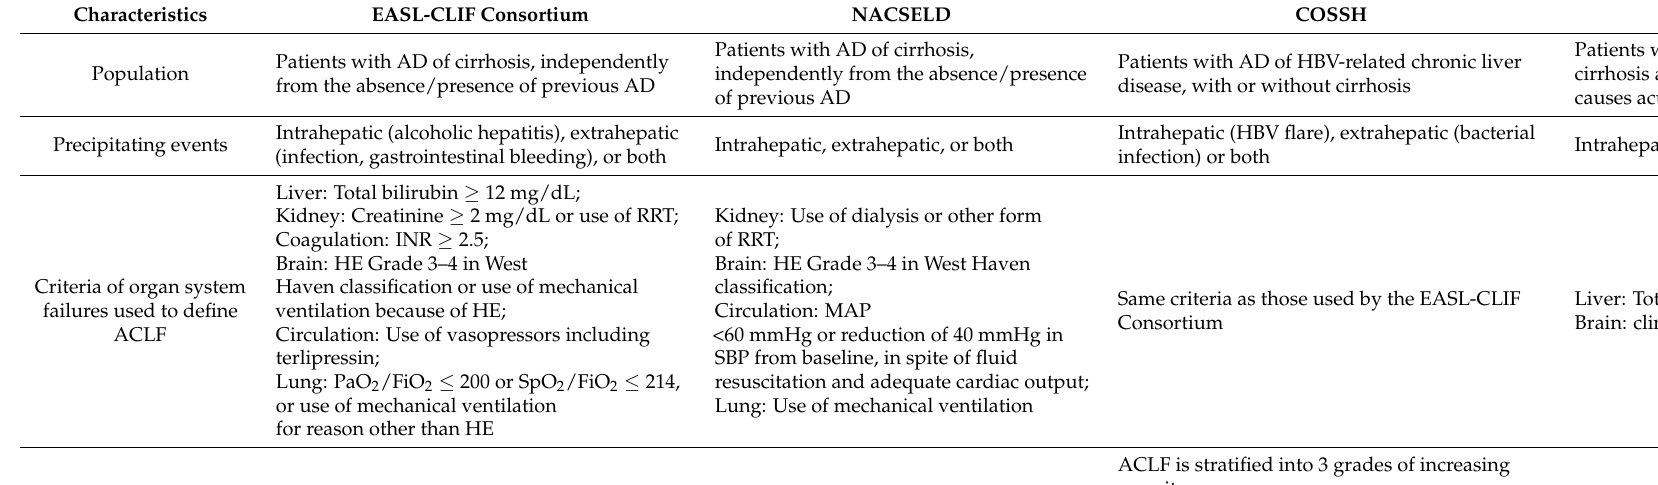
Table 1. Definitions, diagnostic criteria, and stratification of ACLF used by the four major international consortia